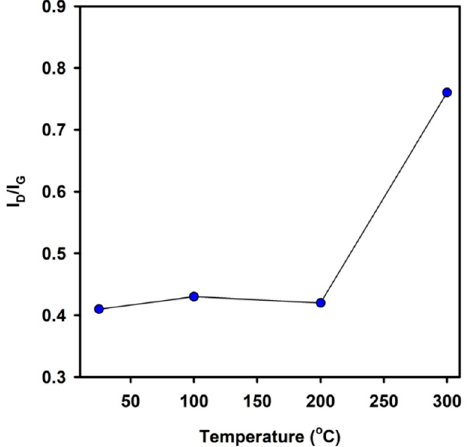
Figure 8. I D /I G plot with the test temperature for a-C-H.